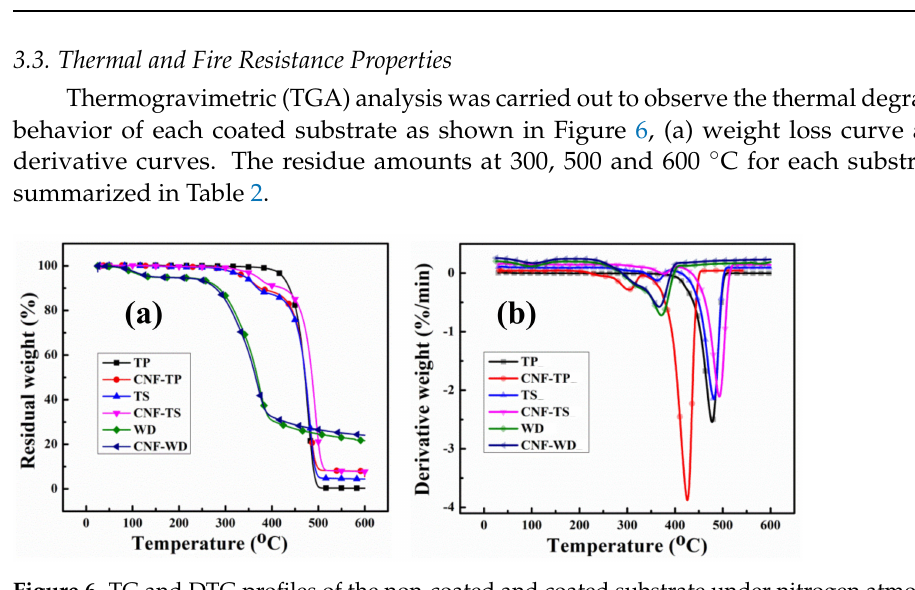
Figure 6. TG and DTG profiles of the non-coated and coated substrate under nitrogen atmosphere. Table 2. Thermal parameters obtained from TGA